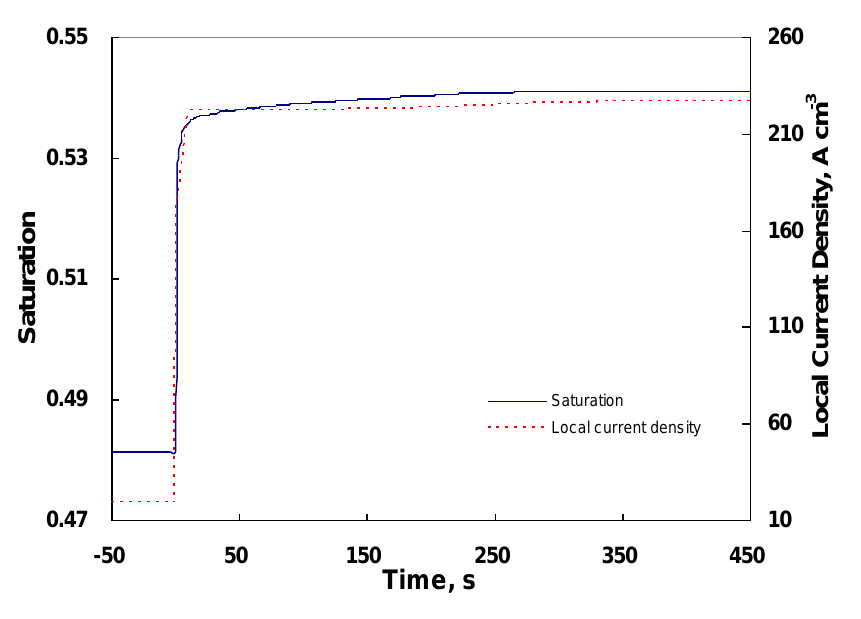
Figure 4. Response of local current density and saturation in the middle of the catalyst layer during a step change of potential from 0.9 V to 0.4 V. Solid line represents the saturation response and dashed line is the local current density